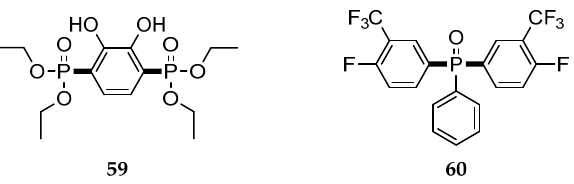
Figure 29. Chemical structure of compounds 59 and 60 .